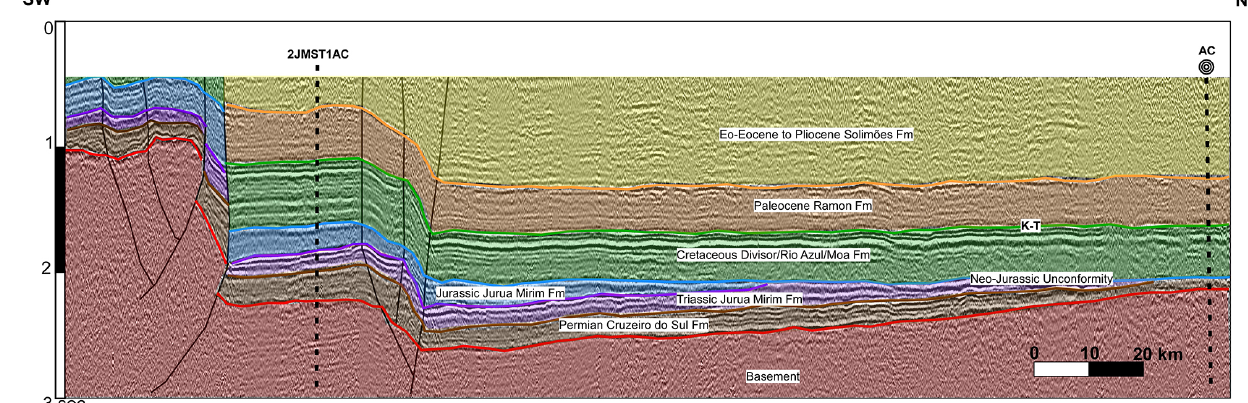
Figure 2. Seismic reflection profile from the Acre Basin (location of line shown in Fig. 1). The proposed drill hole location (AC) and previous drill hole location (2JMST1AC) are